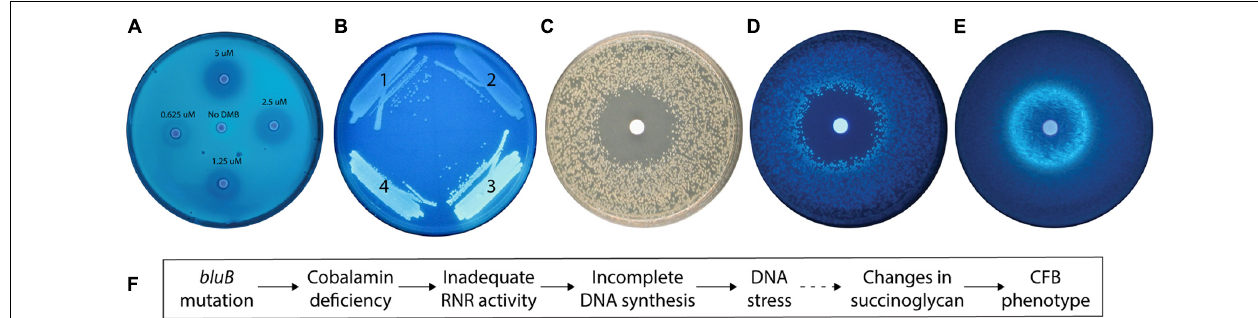
pMS03 (Taga andWalker, 2010). (C) Strain Sm NrdAB + on an LB CF plate with a filter disk containing hydroxyurea, photographed under white light. (D) Same as (C) but photographed under UV light. (E) Fluorescence ofWT S. meliloti on an LB CF plate with a filter disk containing nalidixic acid. Filter disks were applied to the plates at the time of inoculation. (F) Schematic description of the physiological link between the bluB mutation and the CF fluorescence phenotype.The dashed line indicates that the mechanism is